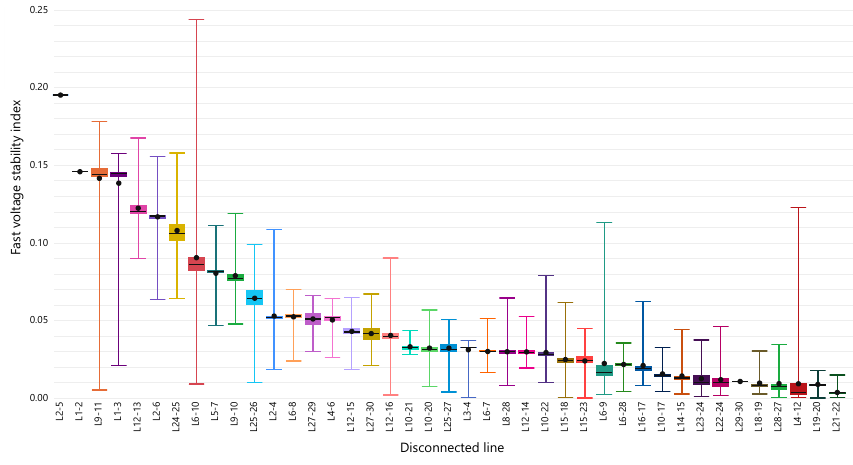
Figure 11. Thirty-bus-bar system: statistical analysis for every contingency scenario.